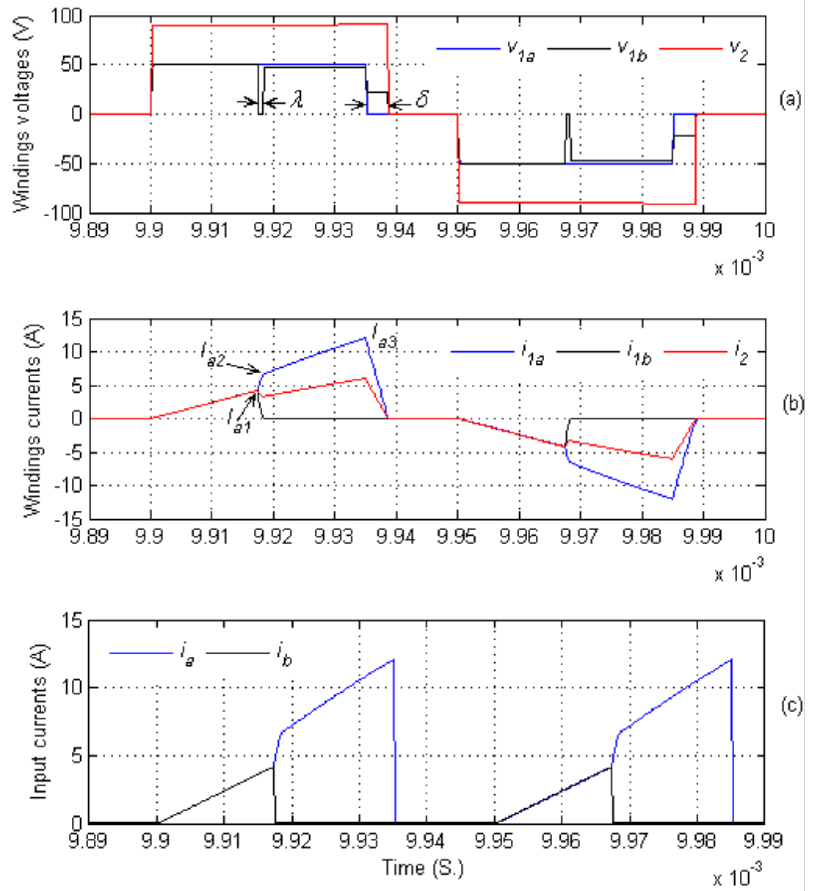
Figure 4. Performance of the proposed high-frequency multi-port DC-DC converter fed from two identical DC sources. ( a ) Voltages in the windings. ( b ) Current in the windings. ( c ) DC-side input